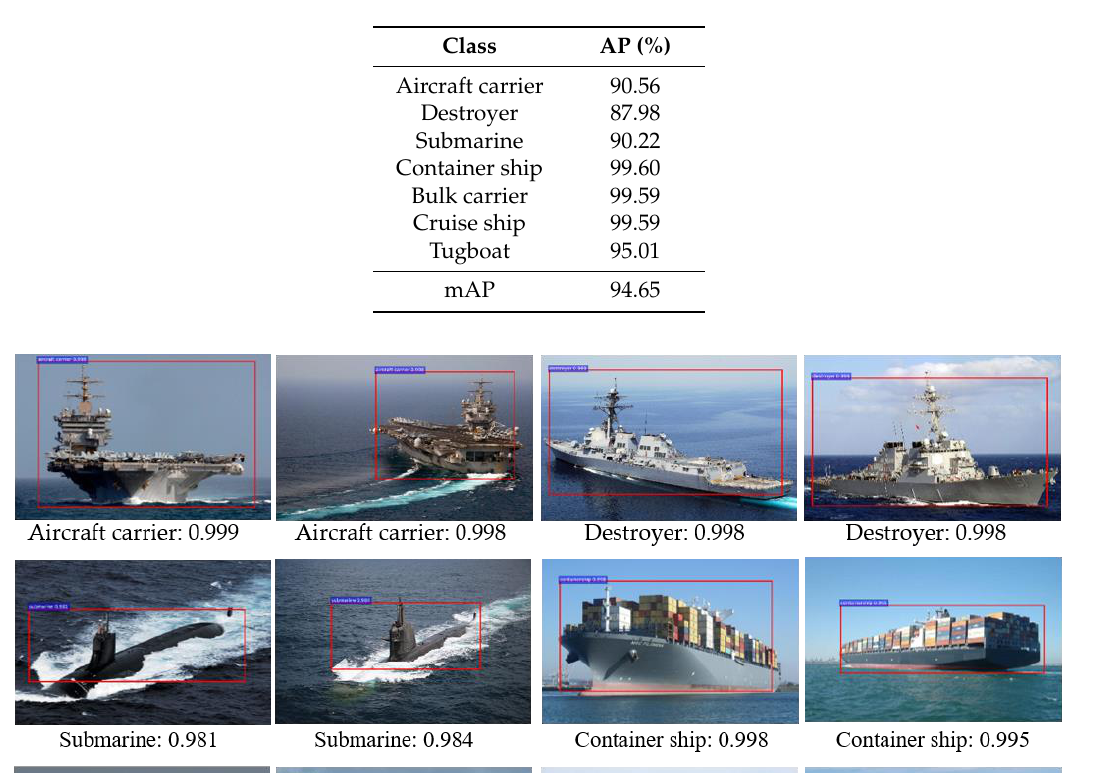
Table 3. Results of the single image detection.